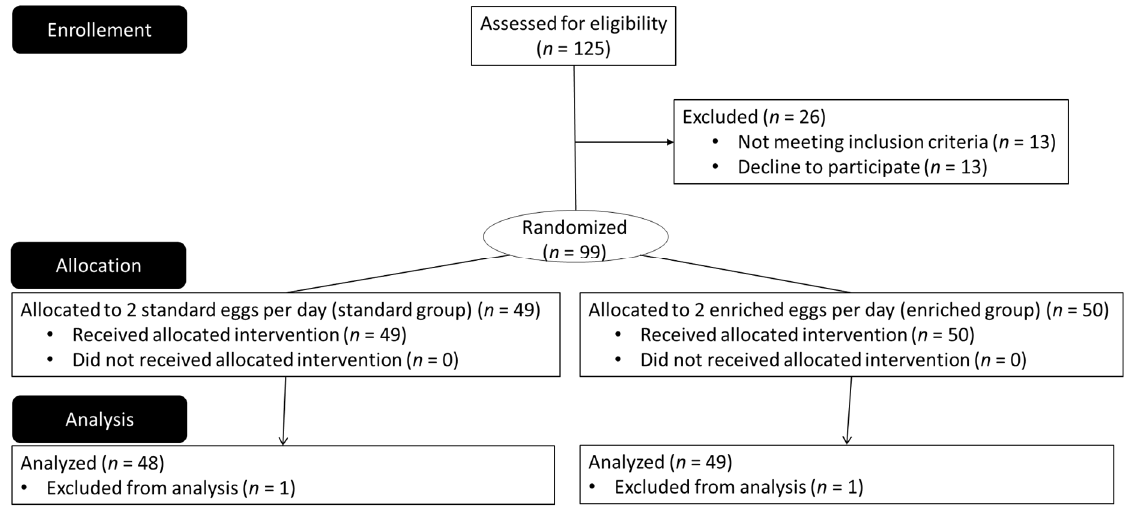
Figure 1. ALGOVUE CONSORT diagram.